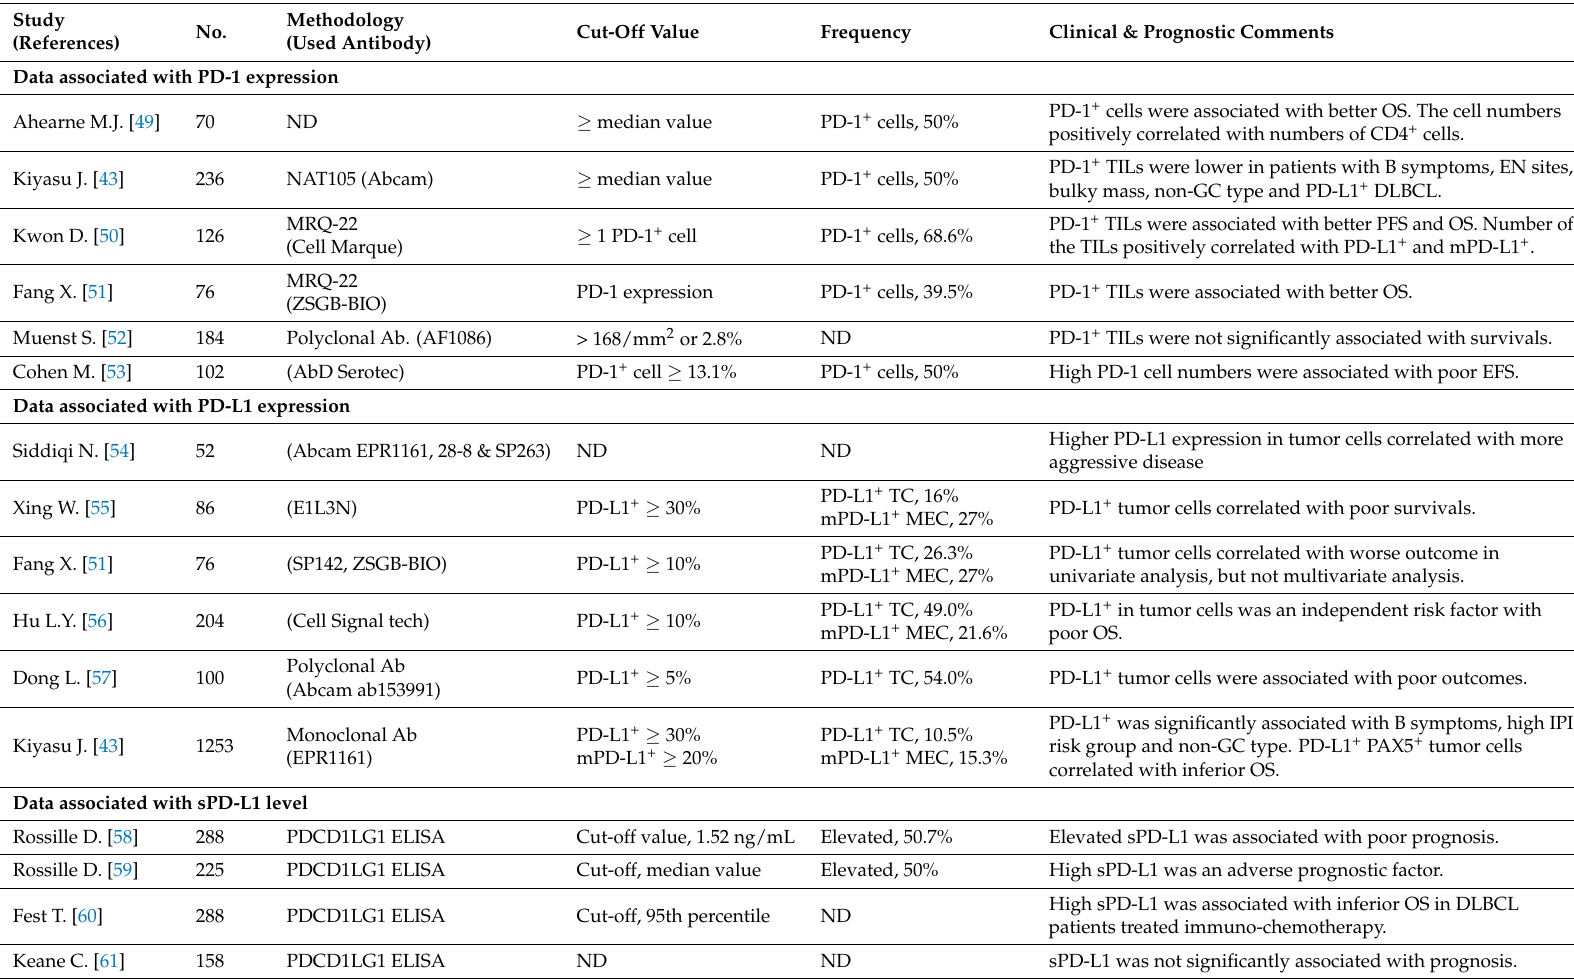
Table 1. Summarized data associated with PD-1/PD-L1/sPD-L1 expression in